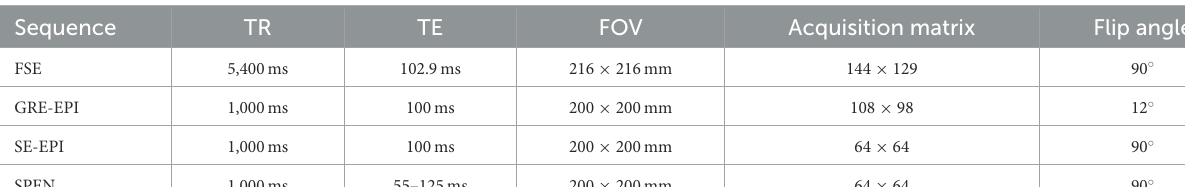
TABLE 1 Parameters of the agar phantom comparison